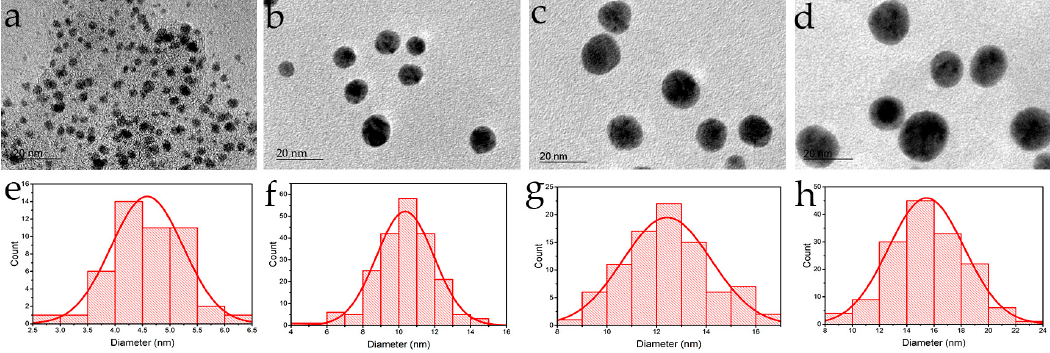
Figure 2. Representative TEM micrographs of AuNPs capped with CB[ 5 ] in ( a ); CB[ 6 ] in ( c ); CB[ 7 ] in ( e ); and CB[ 8 ] in ( g ). Size distribution plots of AuNPs capped with CB[ 5 ] in ( b ); CB[ 6 ] in ( d ); CB[ 7 ] in ( f ); and CB[ 8 ] in ( h ).